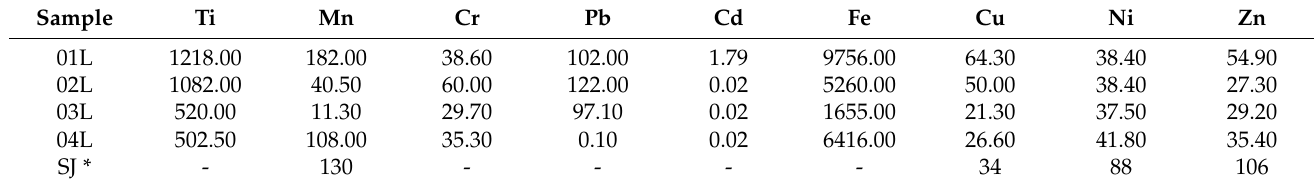
Table 4. Results of ICP analyses of plant samples from the Monchepluton